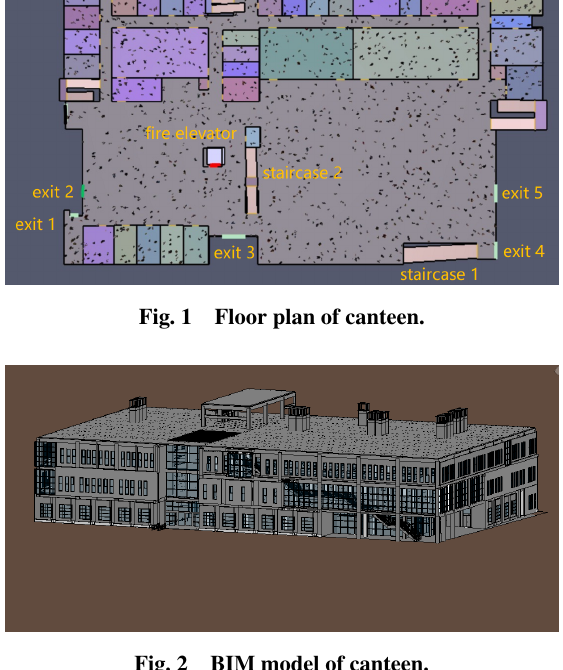
Fig. 2 BIM model of